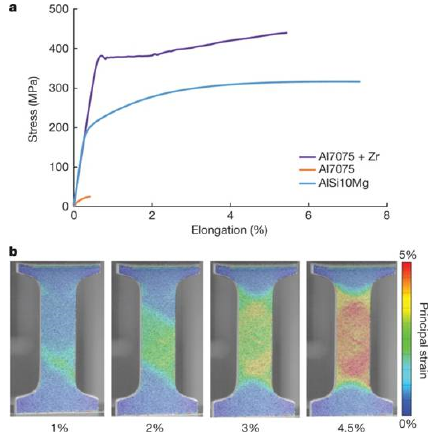
Figure 66. Mechanical testing of 3D-printed aluminum alloys: ( a ) Representative tensile curves of the 3D-printed materials. ( b ) Representative deformation behavior of Al7075+Zr, indicating Lüders band propagation due to the refined grain size. The color scale shows the local principal strain, with the total elongation listed under each panel [185]. Copyright 2017. Adapted with permission from Springer Nature, under the license number 4605280085008 (Figure 4 [185]), dated 7 April 2020.